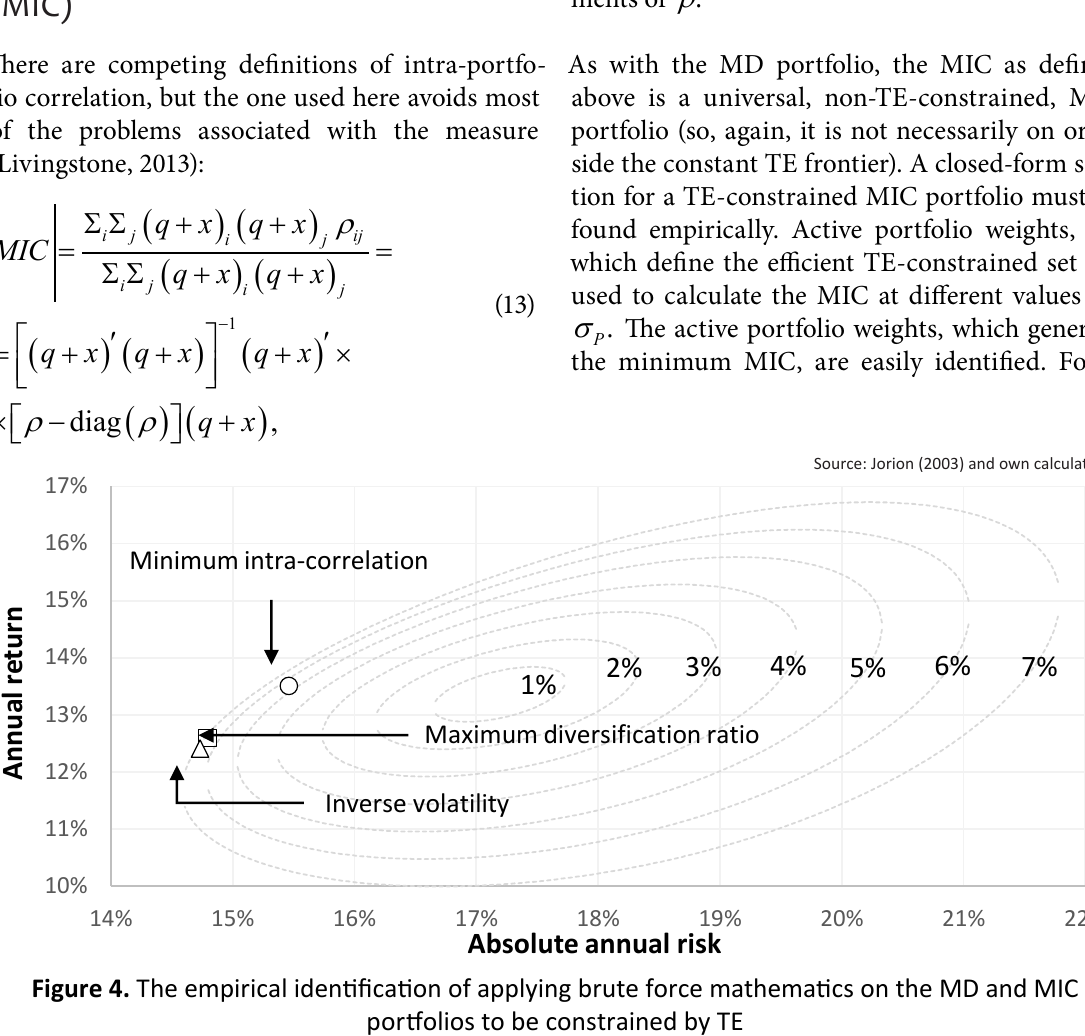
There are competing definitions of intra-portfo- lio correlation, but the one used here avoids most of the problems associated with the measure (Livingstone, 2013):